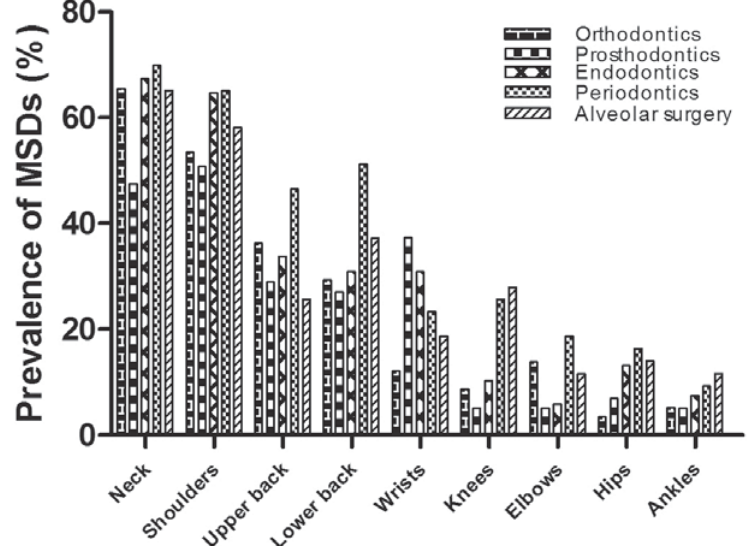
Figure 2- Prevalence of musculoskeletal disorders by regions in different Table 1- Musculoskeletal disorders (MSDs) prevalence at various regions in different dental specialties